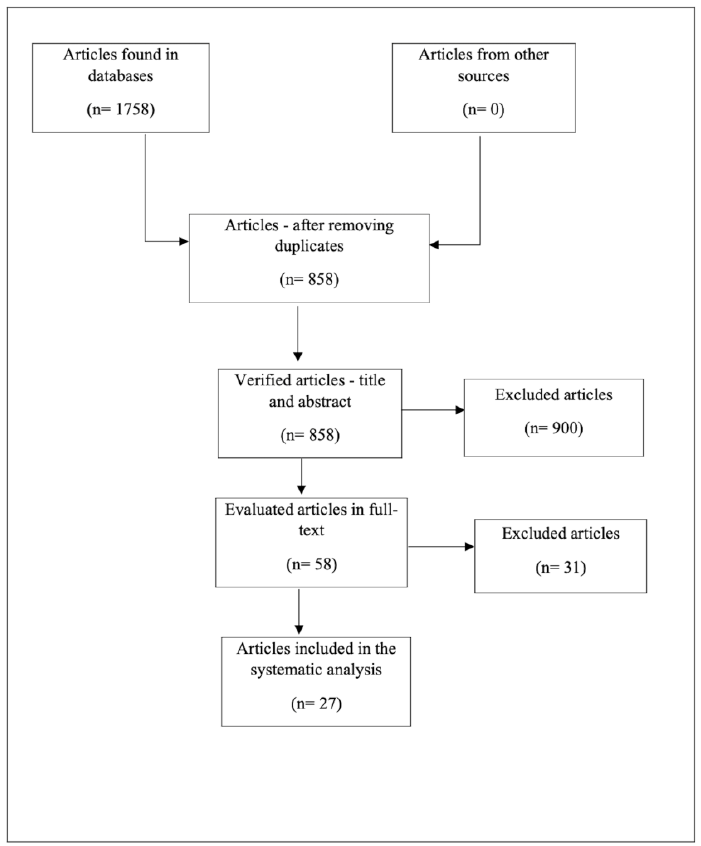
Figure 1. Diagram representing the inclusion of studies.